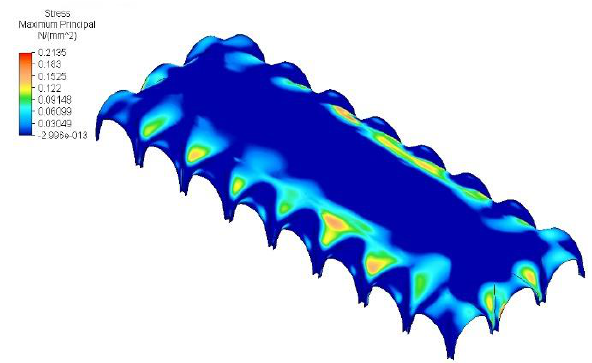
Figure 11. Total σ 11 – principal stress values